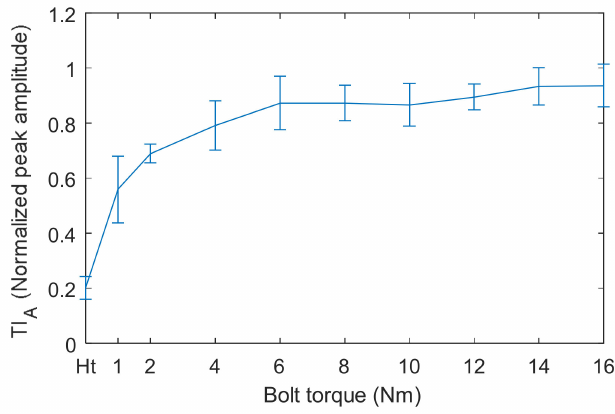
Figure 6. TI A measured by TR method versus bolt torque for single bolt structure.